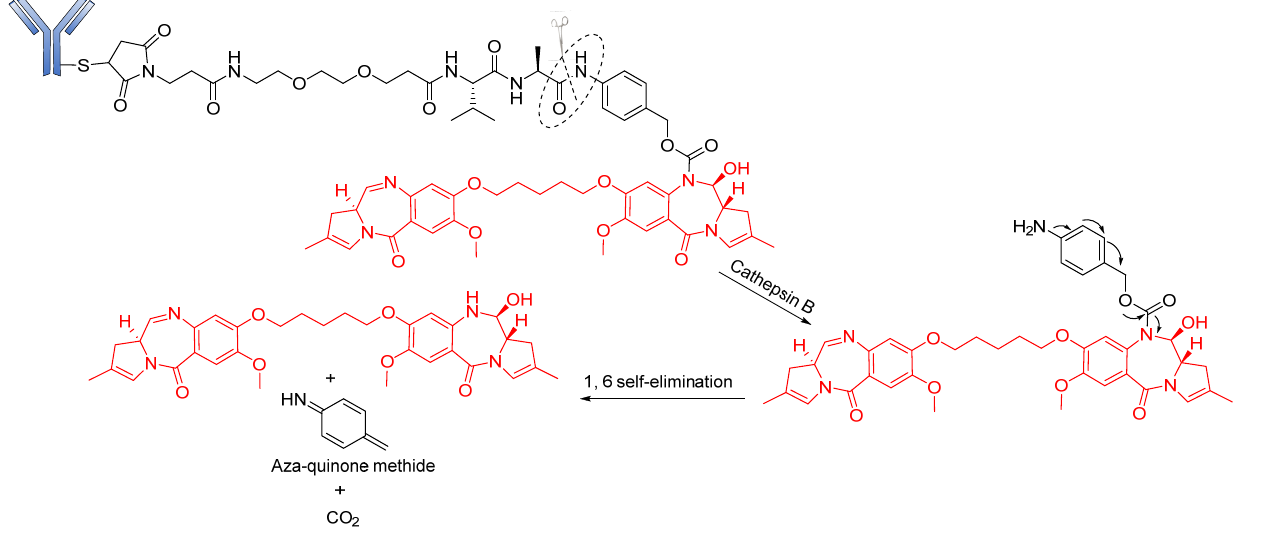
Figure 9. Cleavage mode of Brentuzumab vedotin.